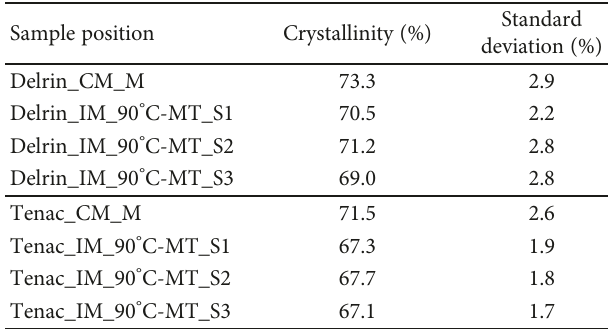
Figure 11: PLM images of the cross section of injection-molded plates. Overview and details for “ Delrin_IM_90 ° C-MT_S3 ” (a – c) and “ Tenac_IM_90 ° C-MT_S3 ” (d – f). Table 8: DSC crystallinity of compression- and injection-molded POM